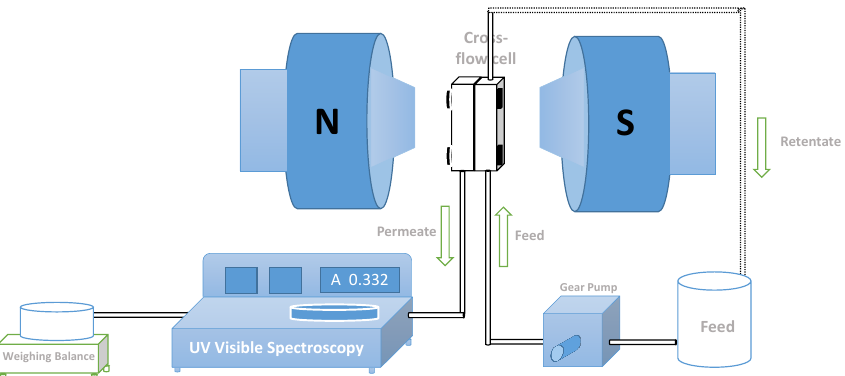
Figure 1. Scheme of the crossflow filtration cell between the magnetic poles with on-line monitoring of protein concentration in the permeate stream by coupling inline a UV-Visible spectrophotometer.